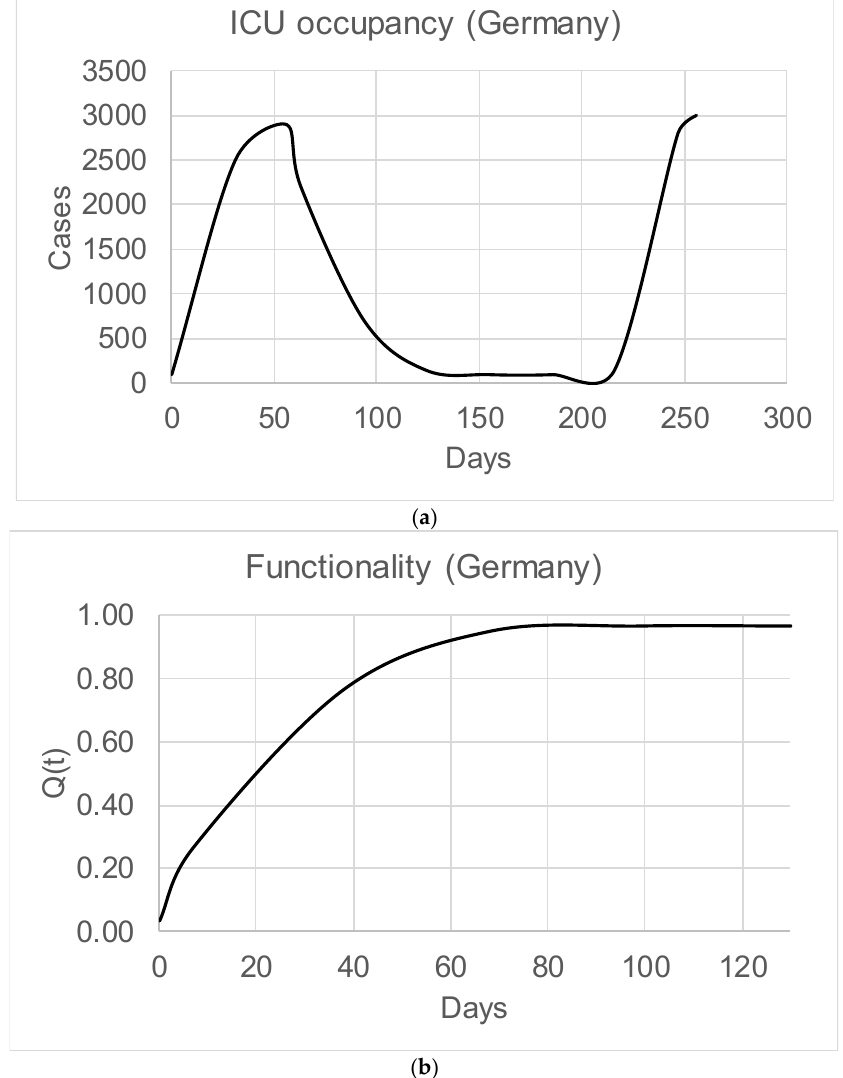
Figure 3. ( a ). Number of COVID-19 patients in ICU in Germany from 1 March 2020 to 26 February 2021. Source: DIVI Intensivregister. ( b ). Health Infrastructure functionality vs. days in Germany (T = 130 days)